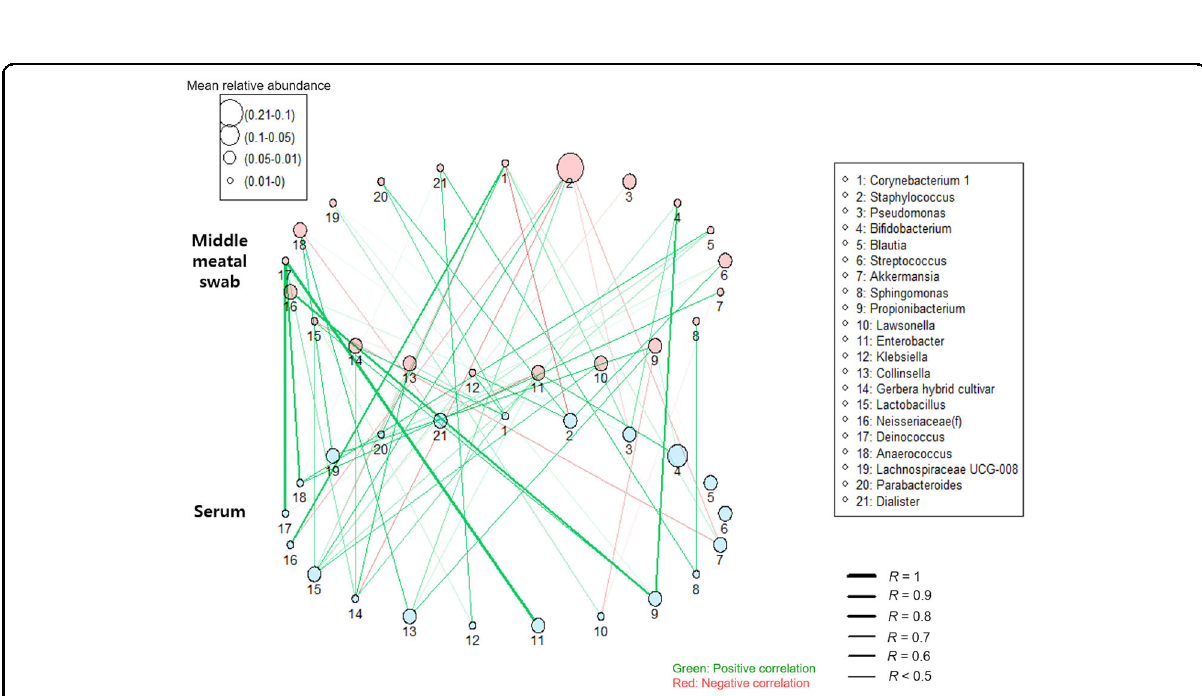
Fig. 3 Signi fi cantly differentially abundant bacterial genera in the sinus according to the surgical outcome. Corynebacterium , Anaerococcus , and Tepidimonas were signi fi cantly less abundant in patients with suboptimal outcomes than in those with optimal outcomes and control subjects. * P < 0.05.